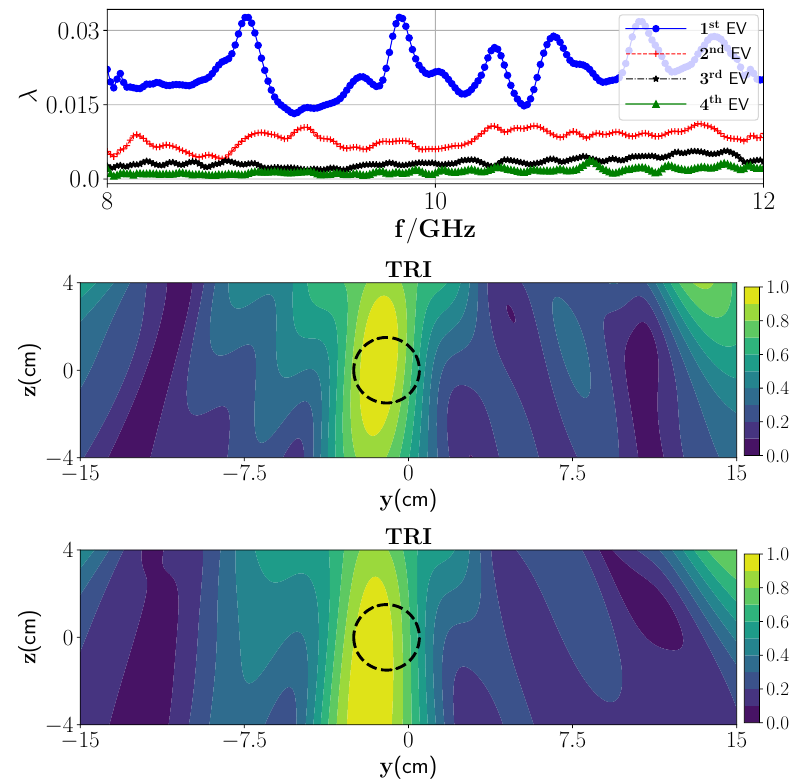
Figure 13. ( Top ) Magnitude of the first four eigenvalues versus the frequencies,( middle ) TRI-DORT reconstruction image of one PTFE Teflon, and ( bottom ) SF-TRI-DORT at 8.07 GHz.